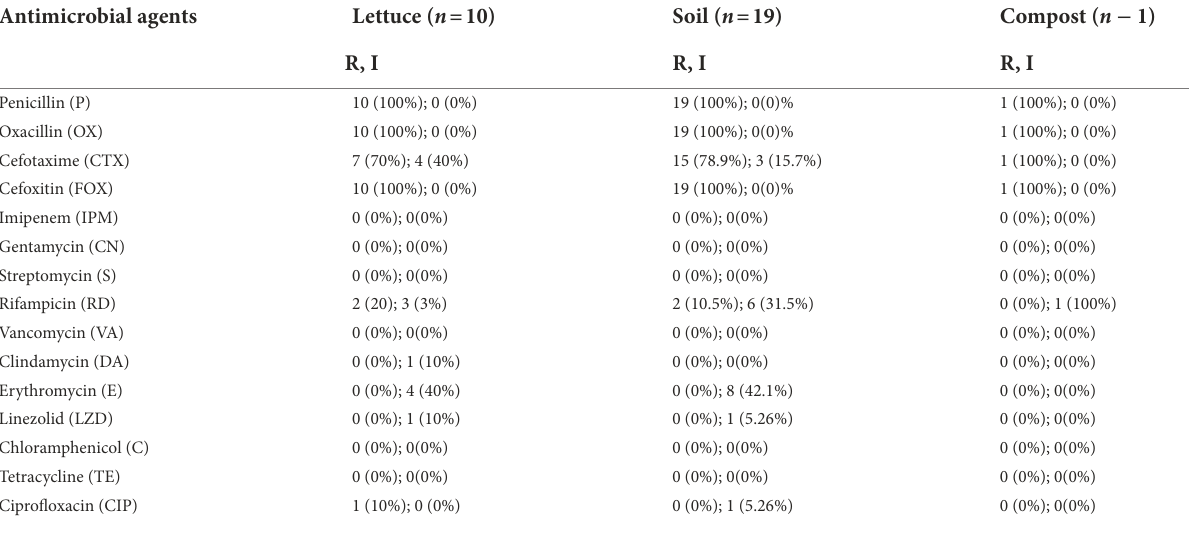
TABLE 6 Antibiotic susceptibility of Bacillus cereus group